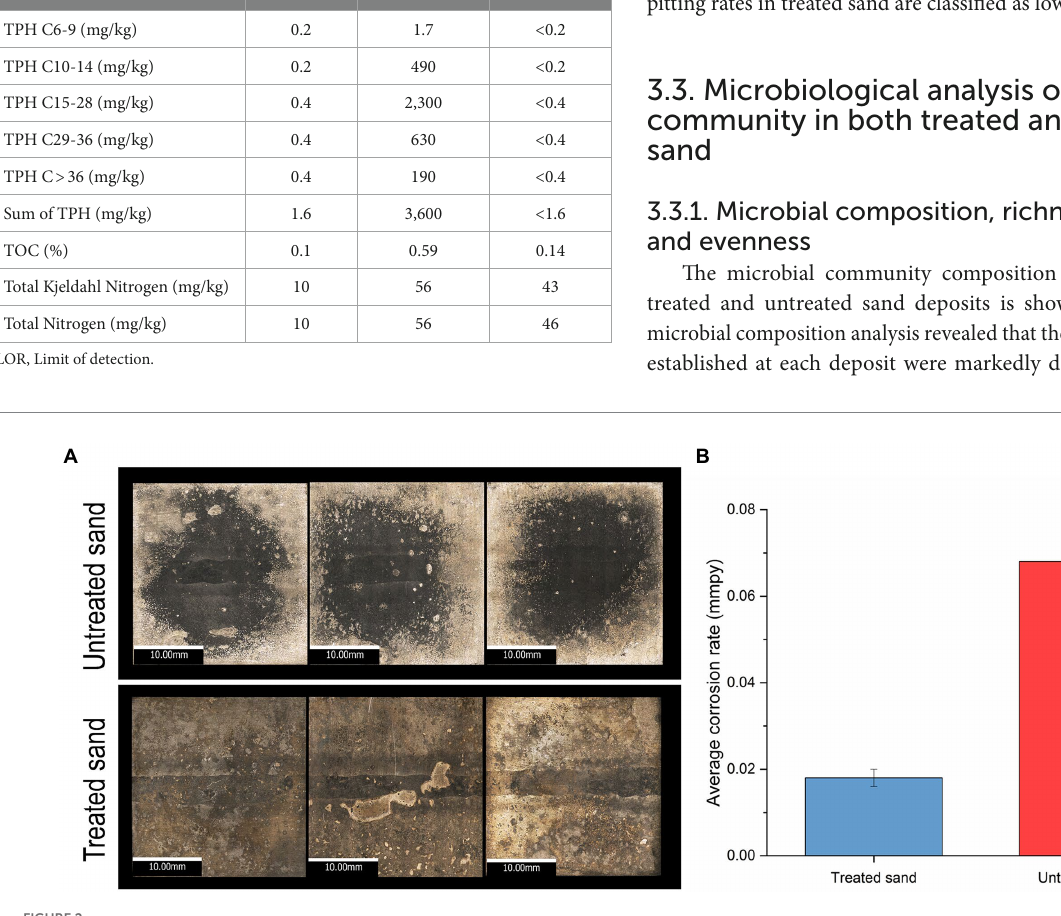
Sand Untreated Treated